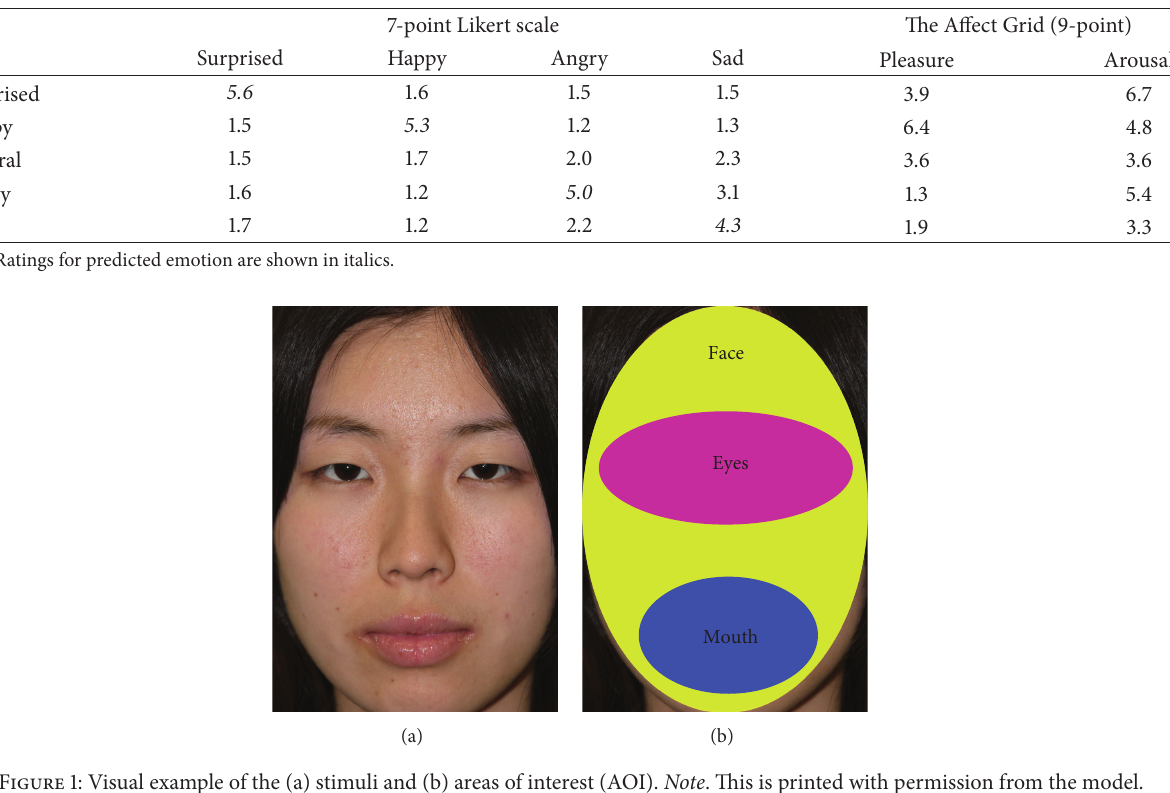
Figure 1: Visual example of the (a) stimuli and (b) areas of interest (AOI). Note . This is printed with permission from the